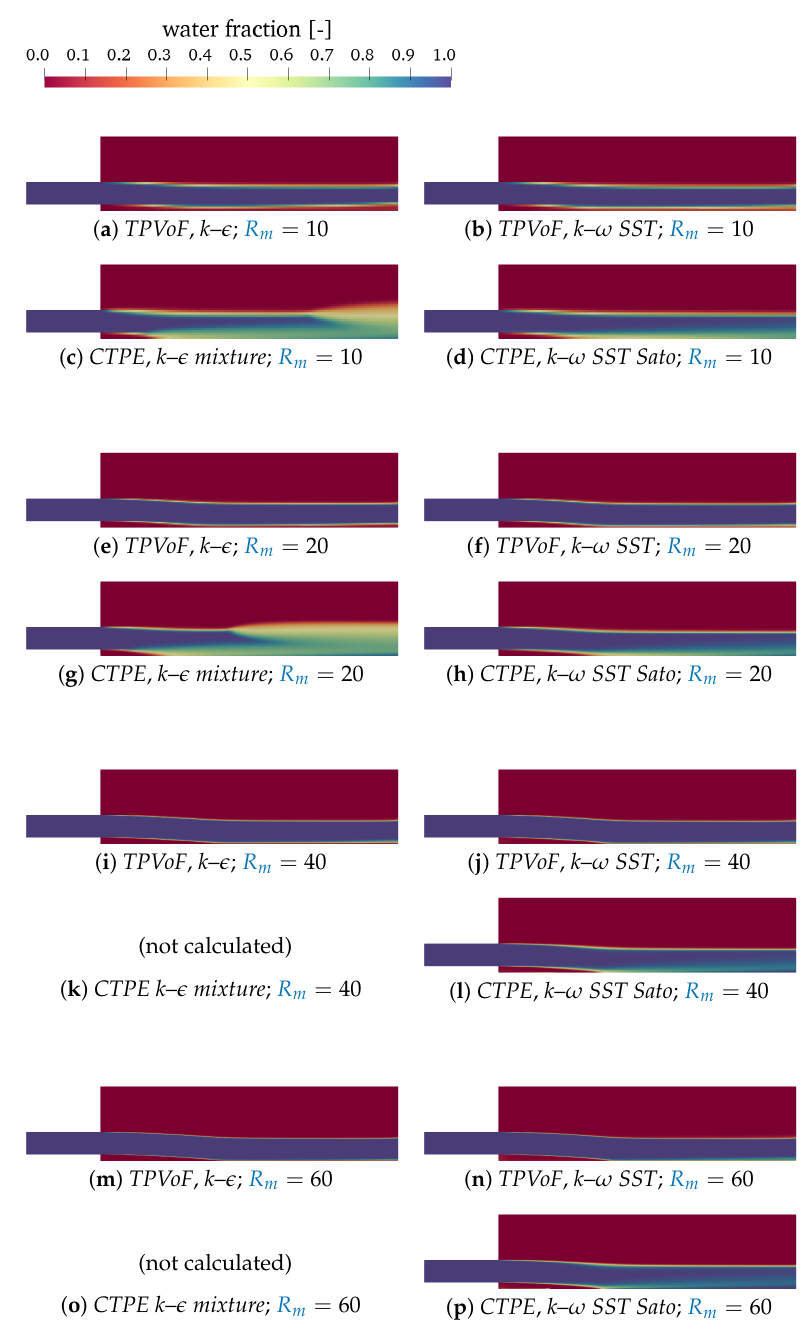
Figure 4. Water fraction ( α ): vertical central